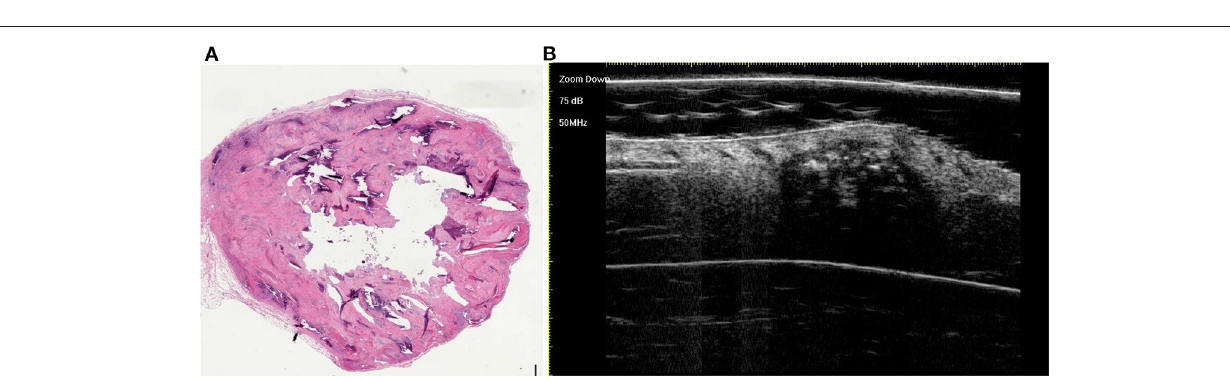
FIGURE 5 | The histological presentation [ (A) HE, original magnification × 10] and ultra-high frequency ultrasound (B) of PM in the early regressive stage, indicating clump